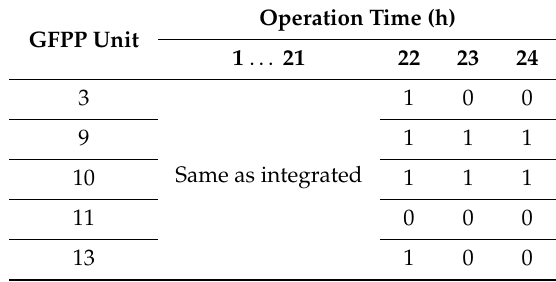
Figure 7. Gas network’s loads and consumed gas by GFPPs in integrated and separated methods. Table 5. Commitment status of GFPPs in separated